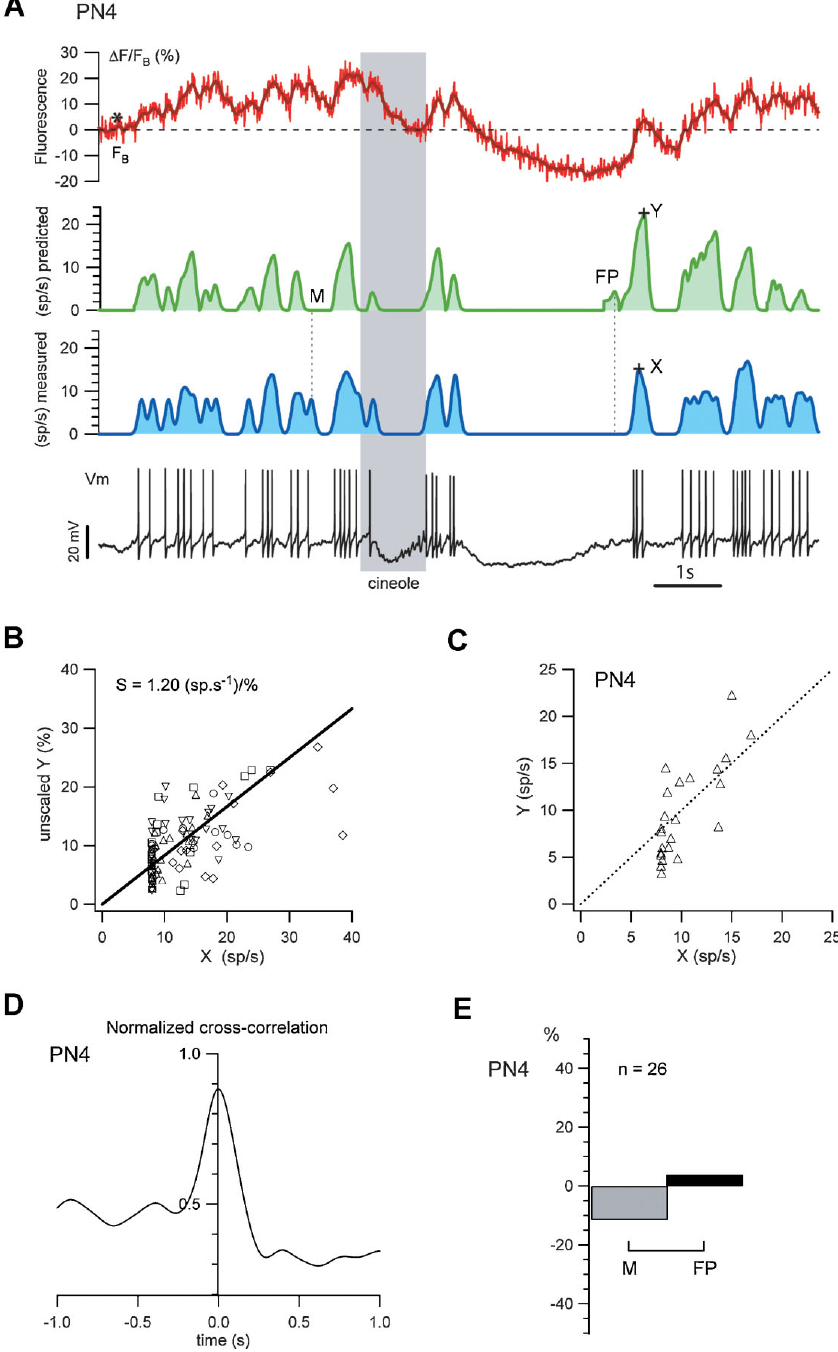
Figure 6. Prediction of one PN’s firing profile from its glomerular calcium signals alone . ( A ) Using the rules described in the text, we use the Gaussian- smoothed ∆ F/F B trace (dark red) to estimate the PN’s discharge with ∼ 50ms resolution. Stippled line indicates F B (note that F B (cid:7)= F 0 ). Compare predicted, smoothed firing rate (green trace) with that calculated by 50-ms-Gaussian smoothing (blue trace) of actual spike discharge obtained from intracellular trace (V m ). X, Y: see B ; M, FP: see E . ( B ) The proportionality constant S between firing rate and calcium-plateau, used as a fixed scaling parameter in our method (see text), was extracted from 5PNs (16-second-long single trials, 1-second odor presentation), each exhibiting moderate firing rate modulations (below 40sp/second) upon stimulation. X and Y mark the spike-related peak amplitudes of, respectively, measured and predicted-smoothed firing rates (as illustrated in A ). ( C ) Dispersion from assumed linearity of Y(X), shown for PN4. ( D ) Cross-correlation (normalized to autocorrelation of measured firing rate) between estimated and measured firing rates; this measure is used as a global accuracy estimator of our predictions: PN4 prediction captures almost 90% of the actual firing rate. A perfect prediction would yield a peak at 1.0. ( E ) Match between predicted and measured firing rate peaks was also assessed piecewise; percentage of missed (M) and false positive (FP) events was measured (see examples in A ). FP events are less than 5% of the total number of real events